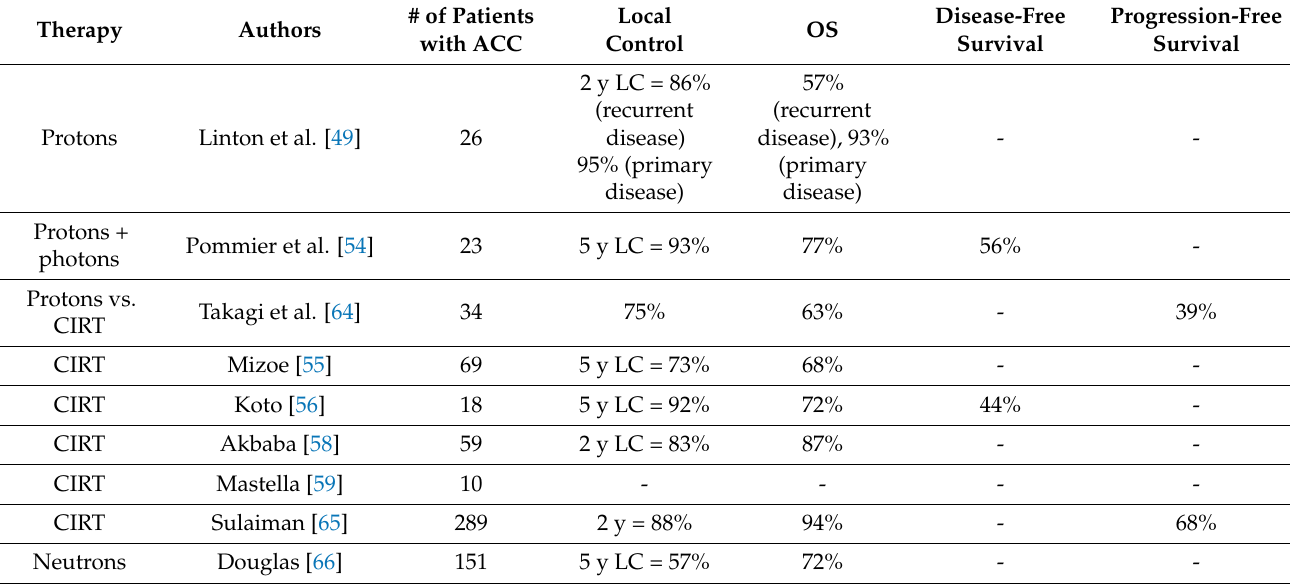
Table 1. Particle radiation therapy. # means